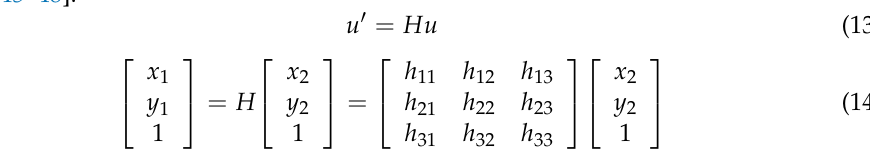
Figure 10. Image plane, red plane, and world plane, in light green, relations by homography.